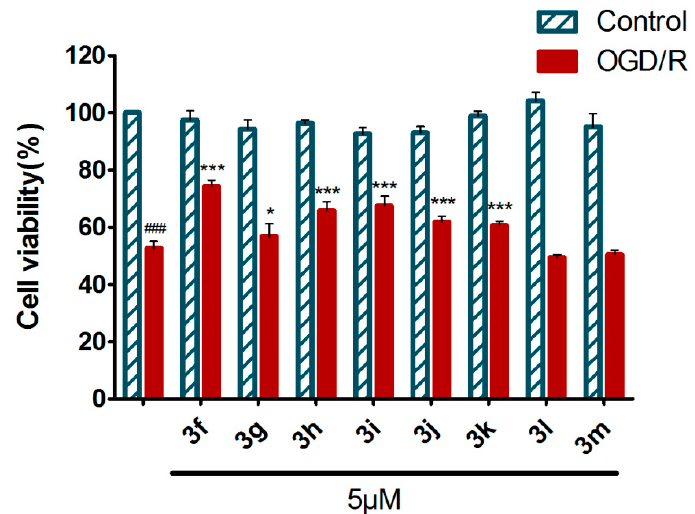
Figure 3. The effect of 3f–m on the cell viability of human neuronal SH-SY5Y cells: The cells were pretreated with different concentrations of 3f–m for 24 h and then exposed to oxygen-glucose deprivation/reoxygenation (OGD/R) for 5.5 h and then reoxygenated for 4 h further. All data are presented as means ± SD (n = 3). ### p < 0.001 vs. control group, * p < 0.05, *** p < 0.001 vs. OGD/R group.